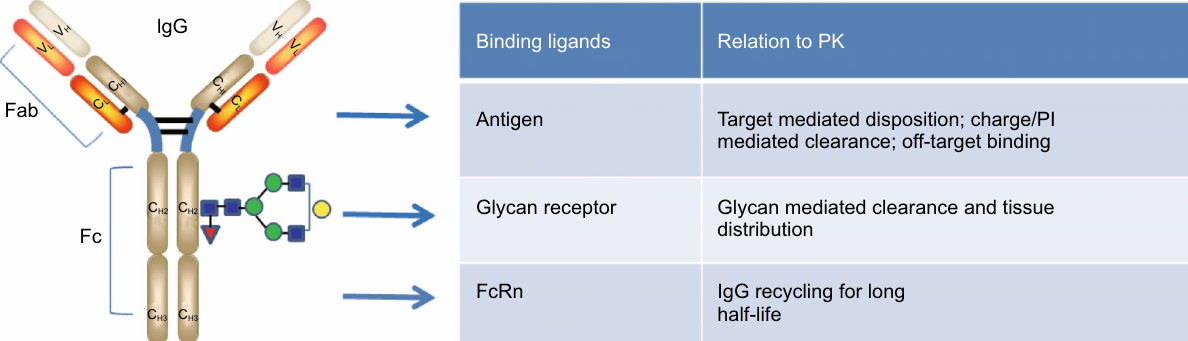
Figure 1. Antibody features that contribute to PK properties.